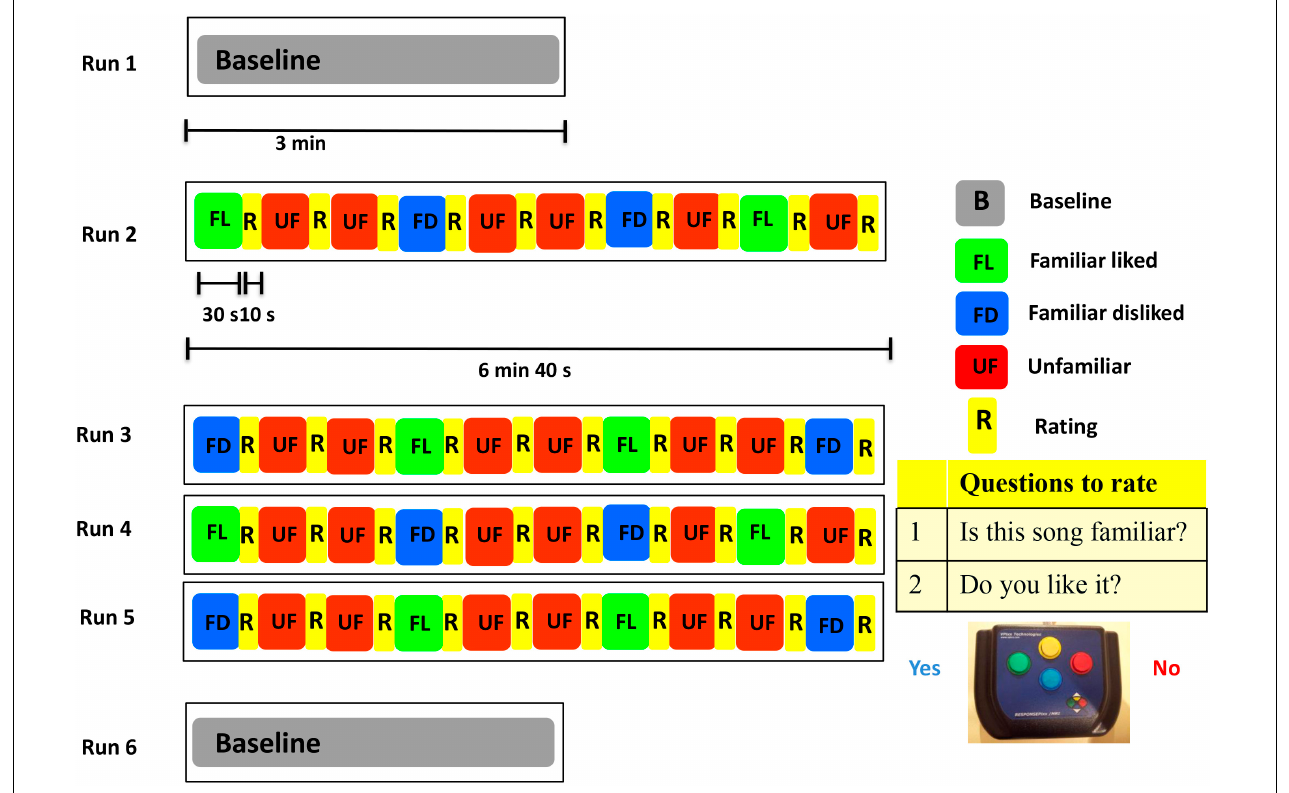
FIGURE 1 | The MEG experimental